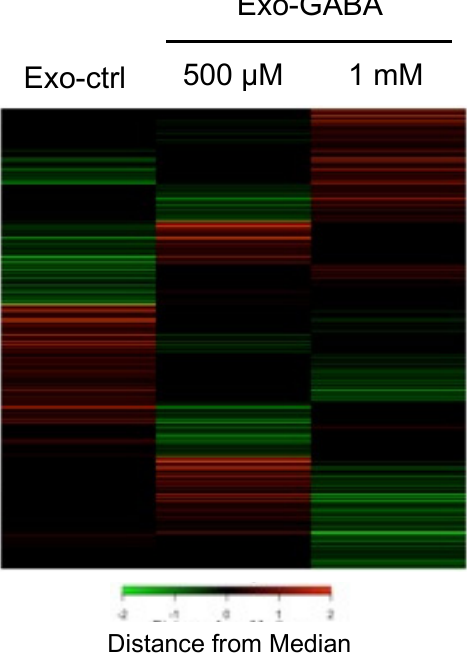
Figure 3. Microarray analysis of genes in exosome-treated SH-SY5Y cells. Heatmap was used to visualize differential expressed genes. Table 2. Functional classification of genes differentially expressed in SH-SY5Y cells treated with exosomes derived from GABA-treated Caco-2 cells.